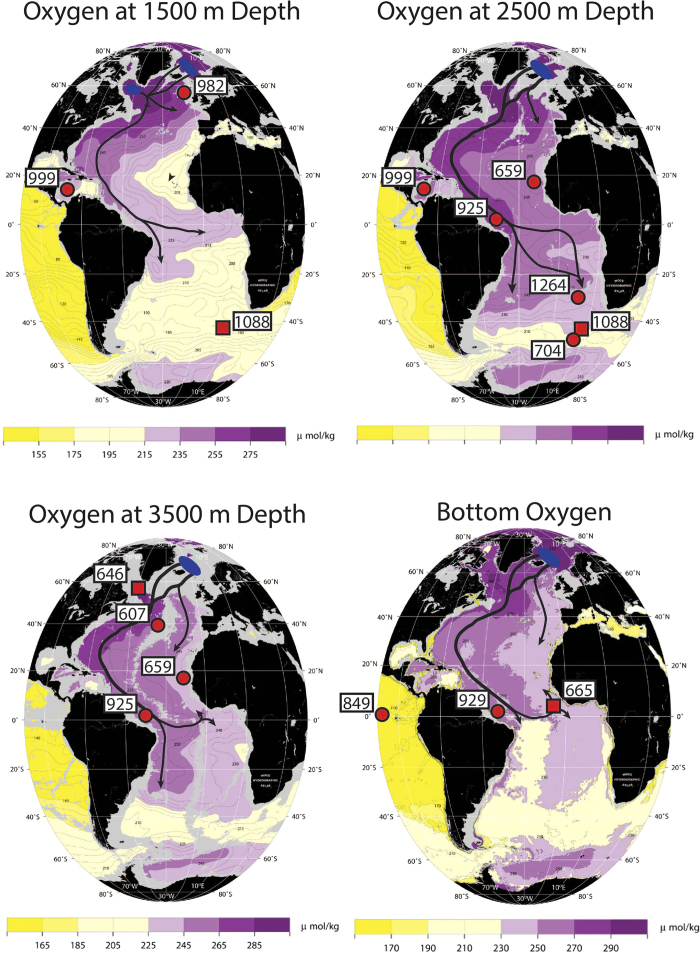
Dissolved oxygen concentration maps of the Atlantic at different depths (modified from the WOCE Atlantic Ocean Atlas 26 to show features of deep-water circulation and the locations of all sites referred to in the text), reflecting aspects of the chemical structure of the deep-Atlantic.Arrows depict general NADW circulation patterns and blue ovals indicate areas of NADW formation. Sites are displayed on maps according to their relevant depth (Table 1). Sites with isotopic data presented in Figs 4, 5, 6 plotted with a red circle, while other sites mentioned in the text are plotted with a red square. Site 999 is situated at 2828 m in the Caribbean, but is expected to record deep-waters entering across the Atlantic-Caribbean sills at ~1600–1900 m depth. High oxygen concentrations result from recent and prolonged contact with the atmosphere, while low oxygen concentrations result from microbial respiration of organic matter over time. NADW, with high oxygen concentrations, is a well “ventilated” water mass, in contrast with deep-waters entering the Atlantic from the south. These maps outline the modern dominance of NADW and highlight the importance of bathymetric constraints and deep-water pathways (e.g. the Deep Western Boundary Current versus interior pathways) in setting gradients in water-mass properties within the Atlantic.